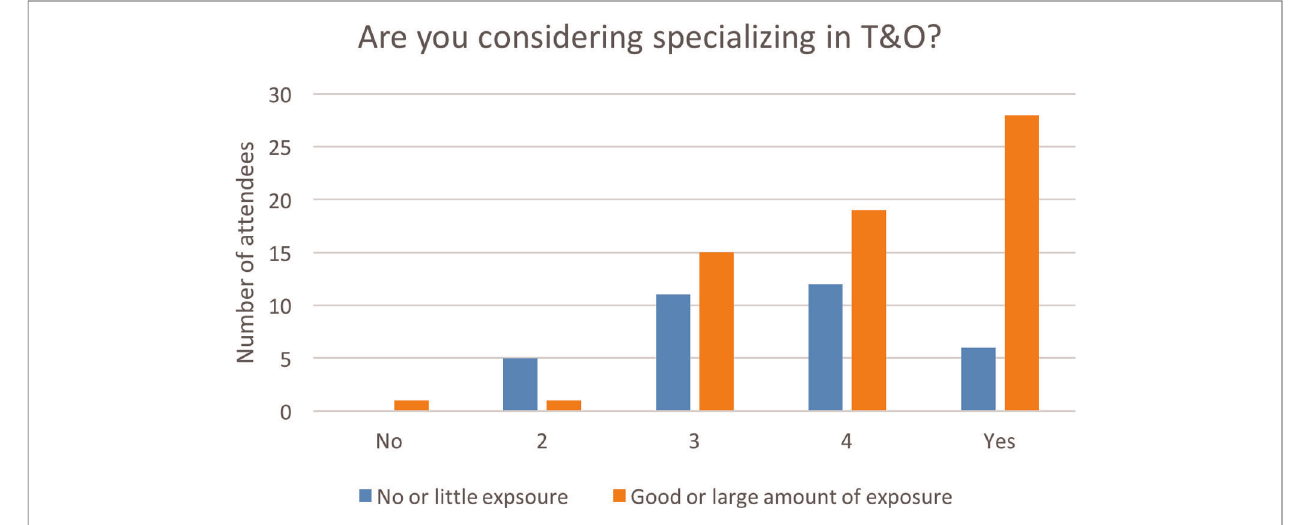
FIGURE 2 | Association between desire to specialise in T&O and exposure to